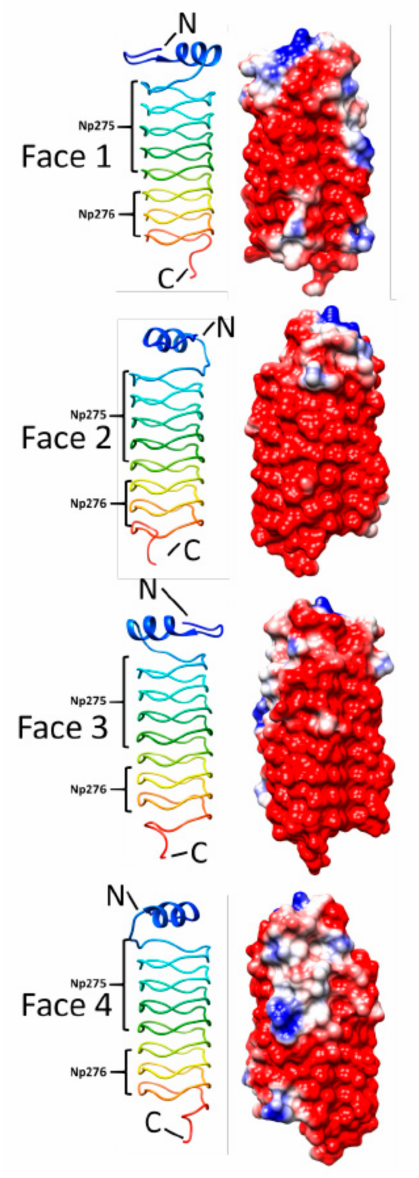
Figure 16. Structure and analysis of Np275/276. Ribbon diagrams of the structure (PDB ID: 2J8K) for four